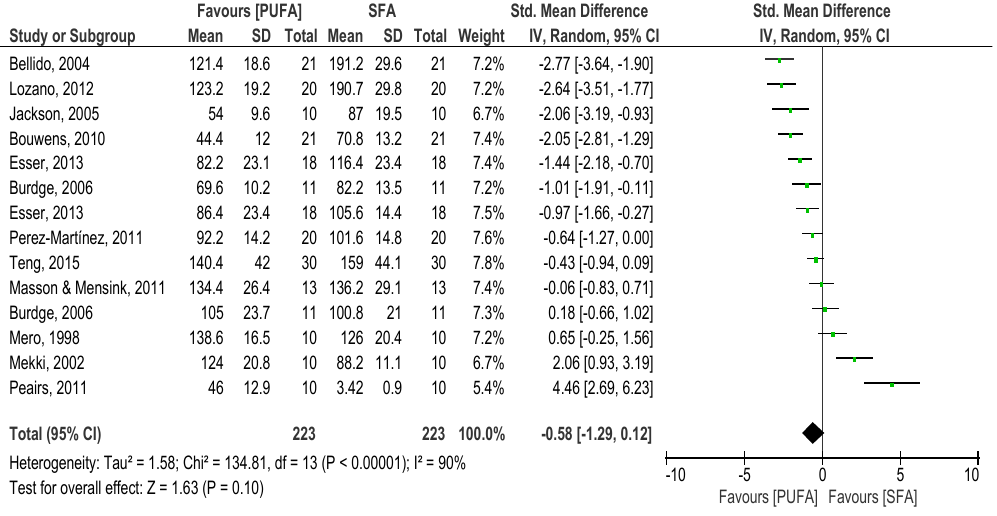
Figure 3. Forest plot of postprandial triglycerides of saturated fatty acids compared to polyunsaturated fatty acids over 4 hours.